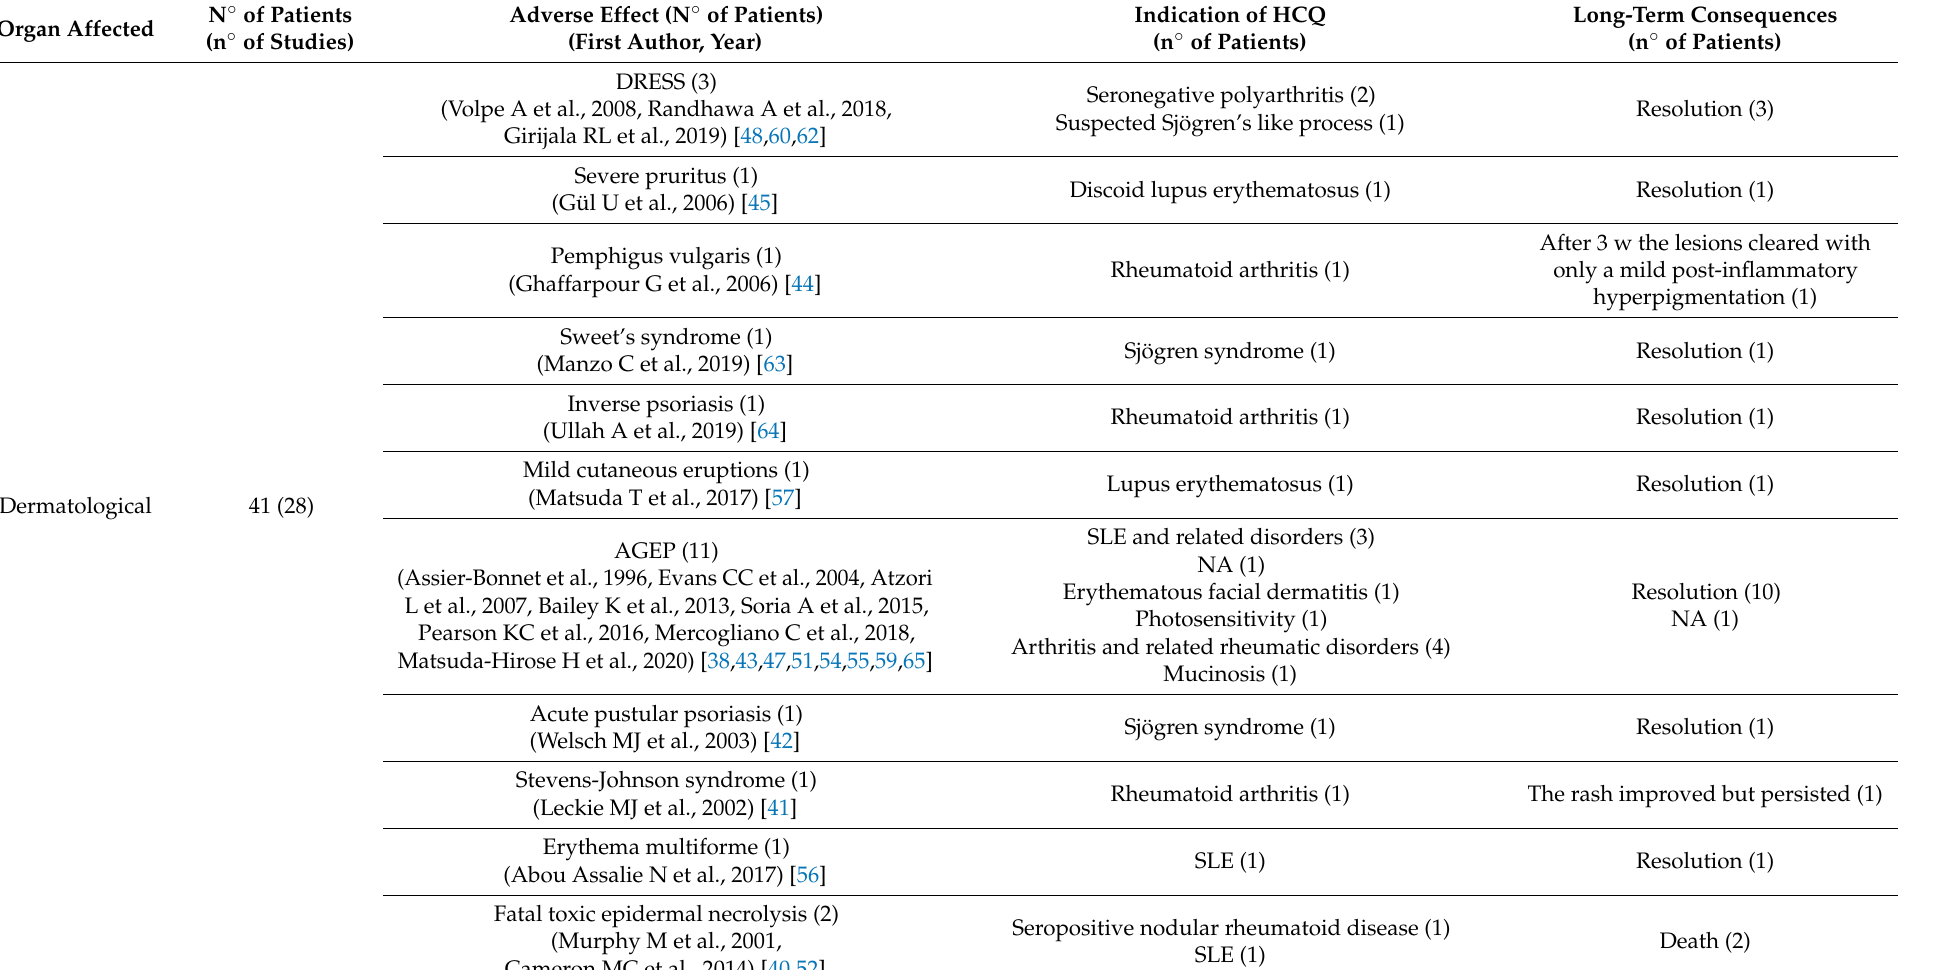
Table 1. Summary of studies included: case reports and case series reports related to HCQ adverse